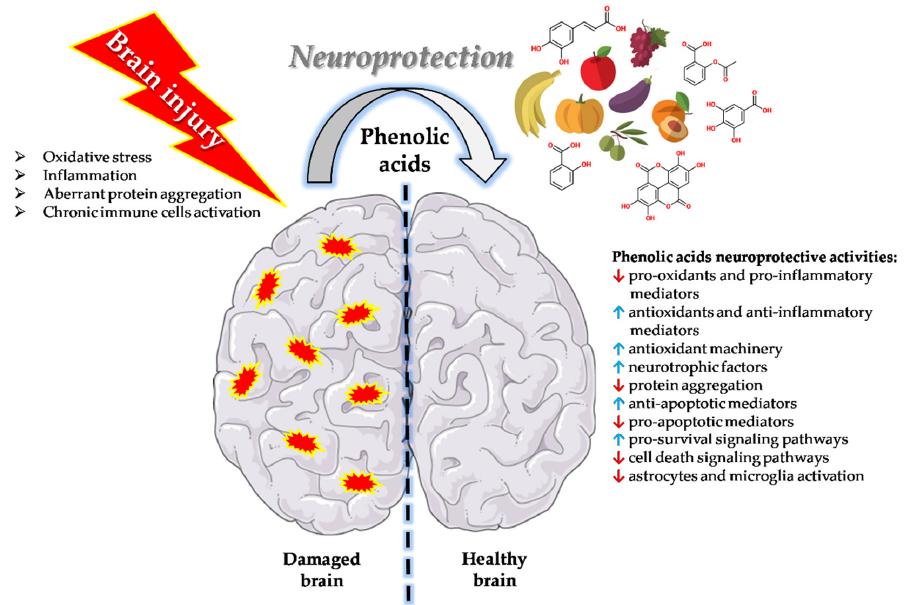
Figure 1. Phenolic acids neuroprotective activities. Phenolic acids can exert neuroprotection